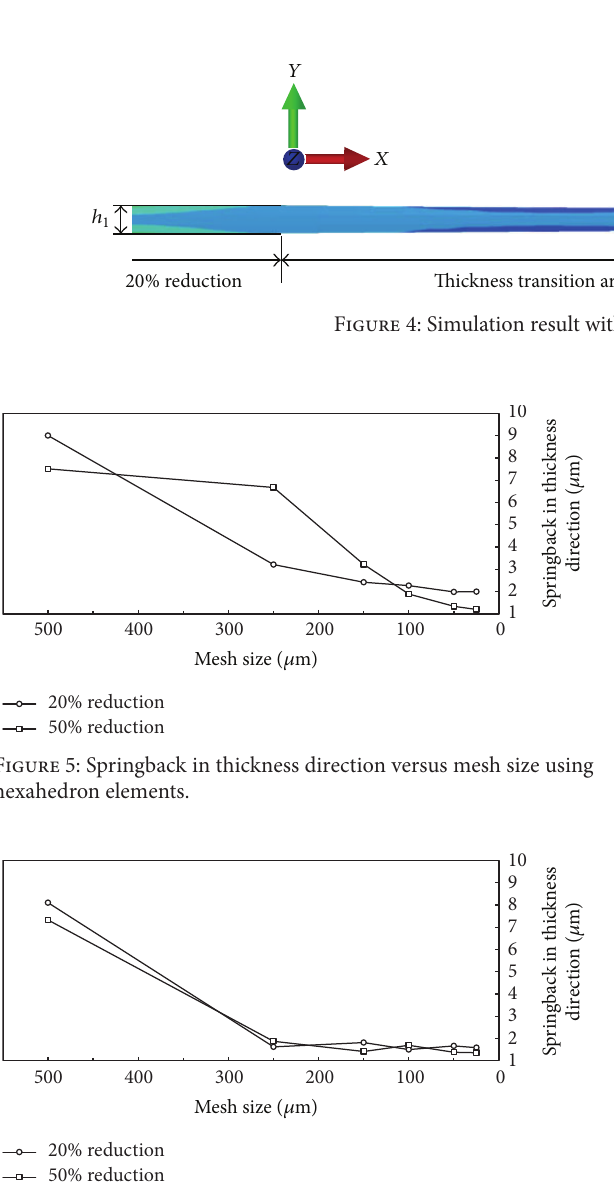
Figure 6: Springback in thickness direction versus mesh size using tetrahedron elements.